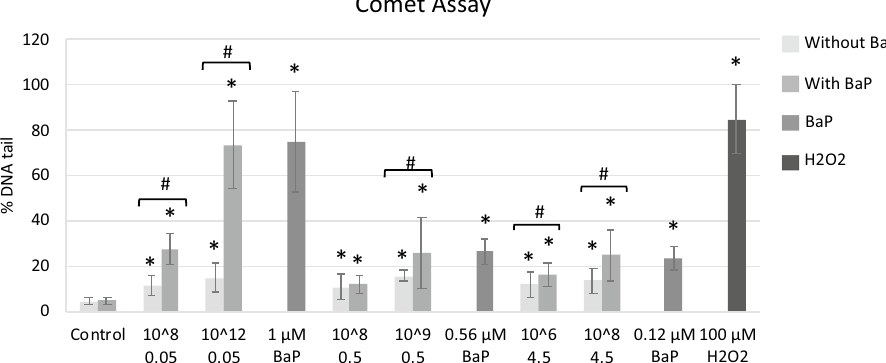
Figure 8. DNA damage in mussel hemocytes exposed for 24 h to 0.05 µm NPs, 0.5 µm MPs and 4.5 µm MPs alone or in combination with BaP, to BaP alone and to 100 µM H 2 O 2 (positive control). Data are given as % DNA in tail ± SD (n = 100). * indicates significant differences with respect to controls, # indicates significant differences between NPs/MPs alone or with